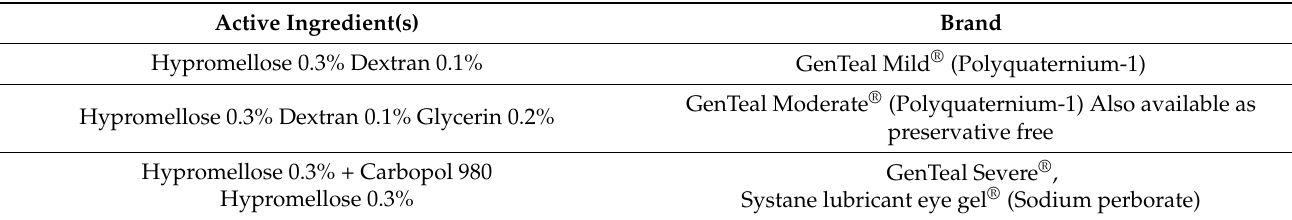
Table 2. Artificial tears containing hypromellose and dextran as